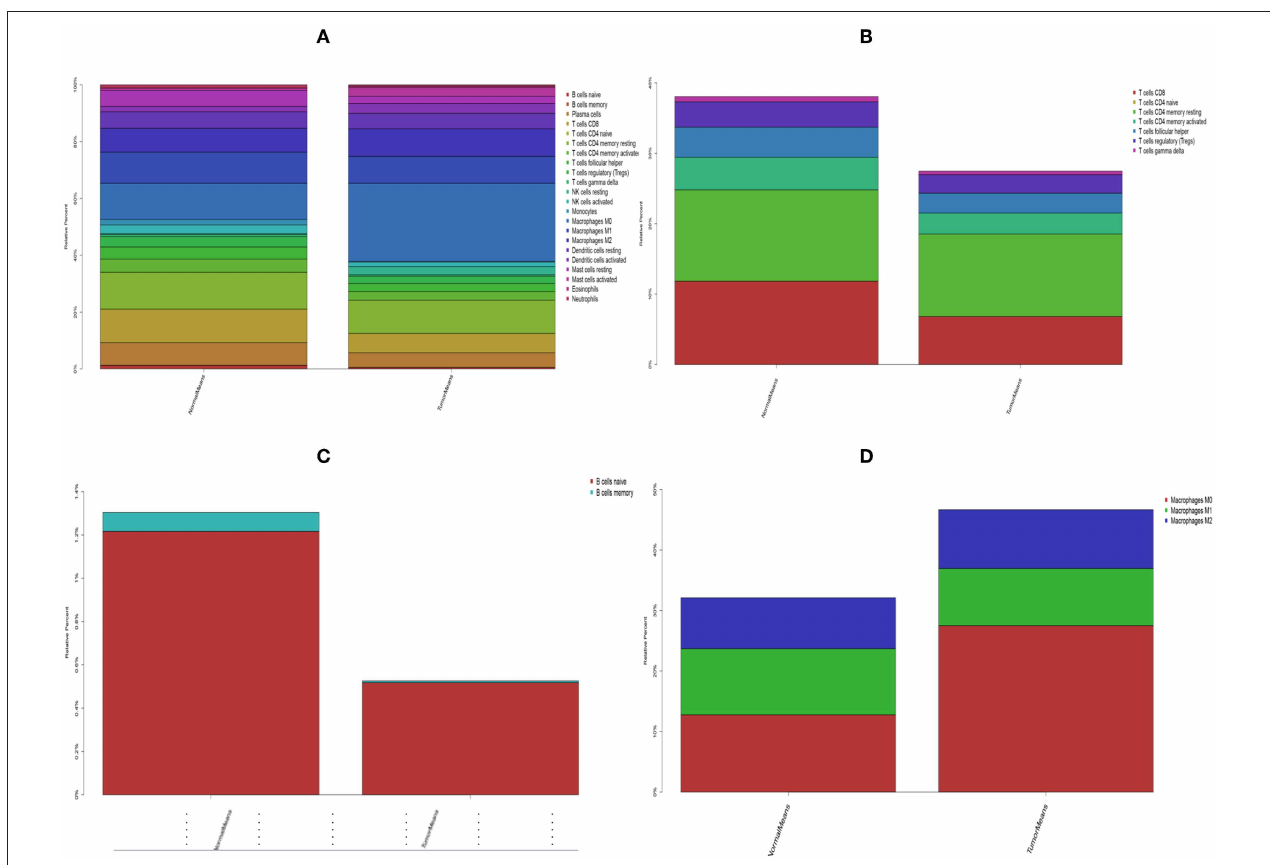
FIGURE 2 | The stacked histogram shows the distribution of 22 immune cell infiltration between HNC adjacent tissues and tumor tissues, including total immune cells (A) , total T cells (B) , total B cells (C) , and total macrophages (D) .